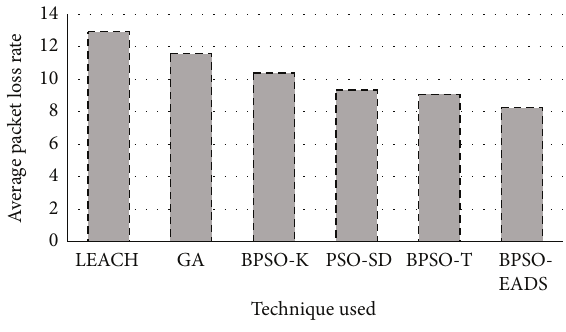
Figure 10: Packet loss rate over 500 rounds.